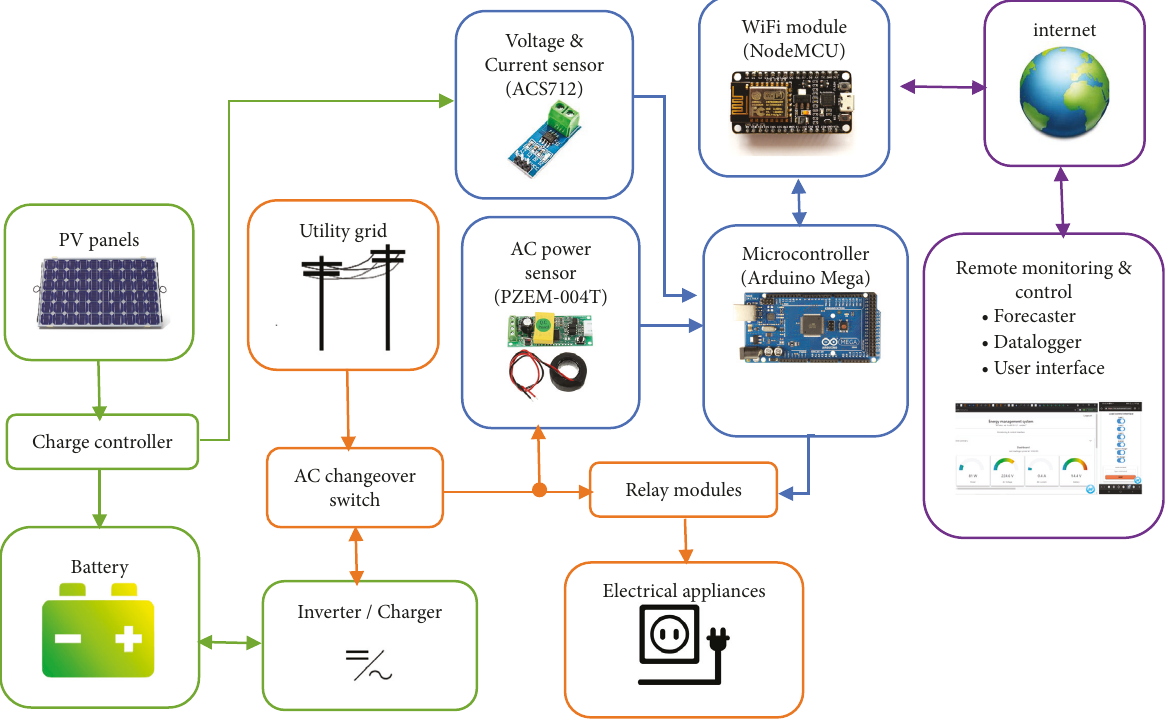
Figure 1: Test site energy management system